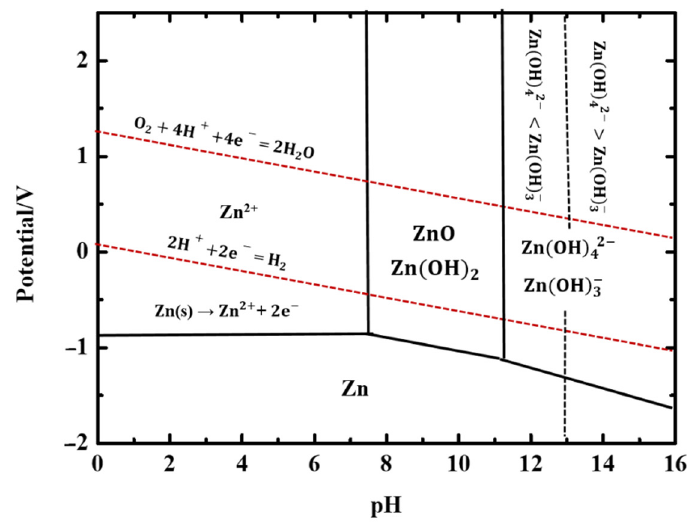
Figure 2. Pourbaix diagram of metallic zinc in water at different pH value. Reprinted with permission from Ref. [18], Copyright 2016, John Wiley and Sons.